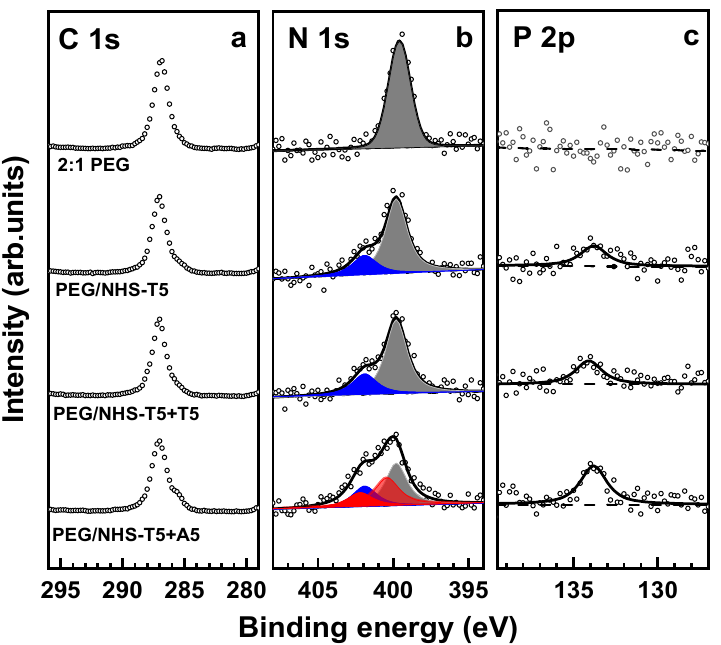
Figure 4. C 1s (a), N 1s (b), and P 2p (c) XP spectra of the original 2:1 PEG film, PEG film exposed to NHS-T5 (PEG/NHS-T5), and PEG/NHS-T5 probe film exposed to mismatching (T5) and matching (A5) target ssDNA. The N 1s spectra are decomposed into individual contributions related to the amine groups in the PEG matrix (dark gray), thymine (blue), and adenine (red). The P 2p spectra are tentatively fitted by a single peak (solid lines) and a linear background (dashed lines).